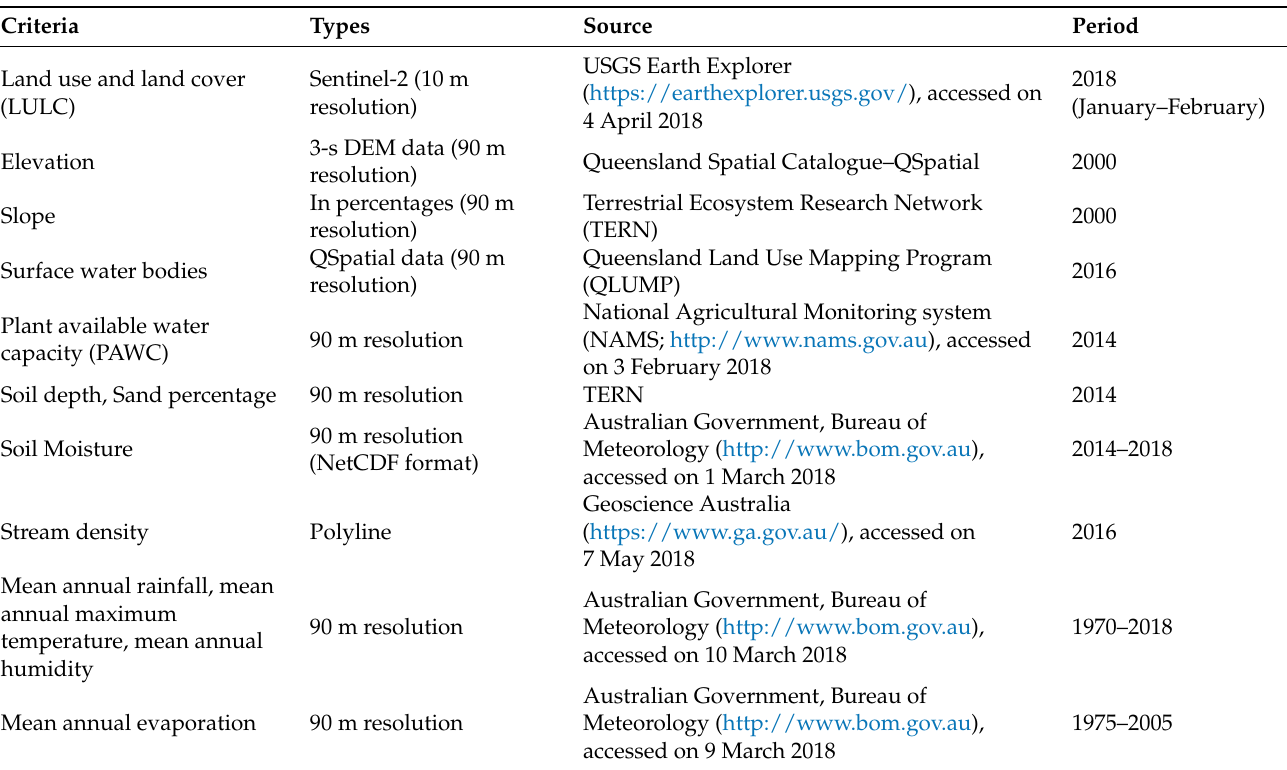
Table 1. The used datasets for drought vulnerability